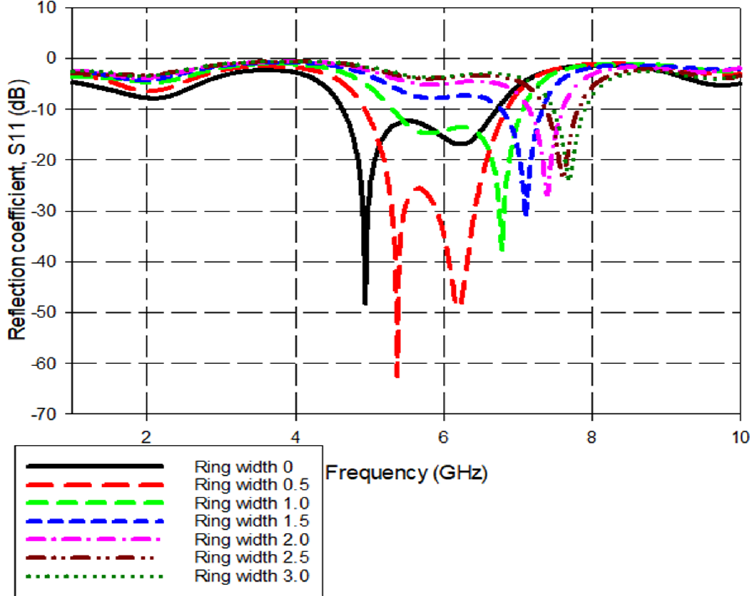
Figure 8. Graph of parameter sweep of ring width against resonance frequency shifting.